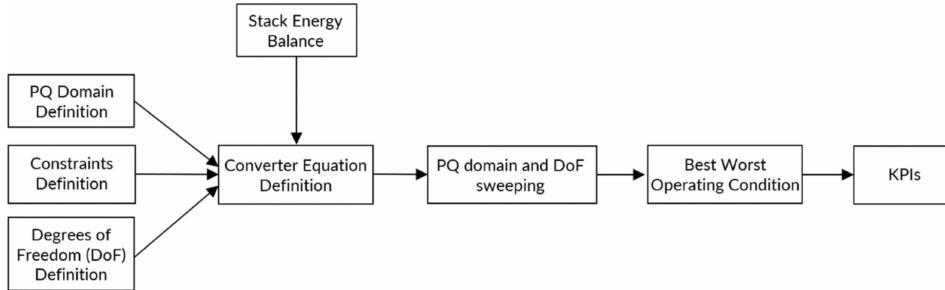
Figure 1. Topology assessment methodology.